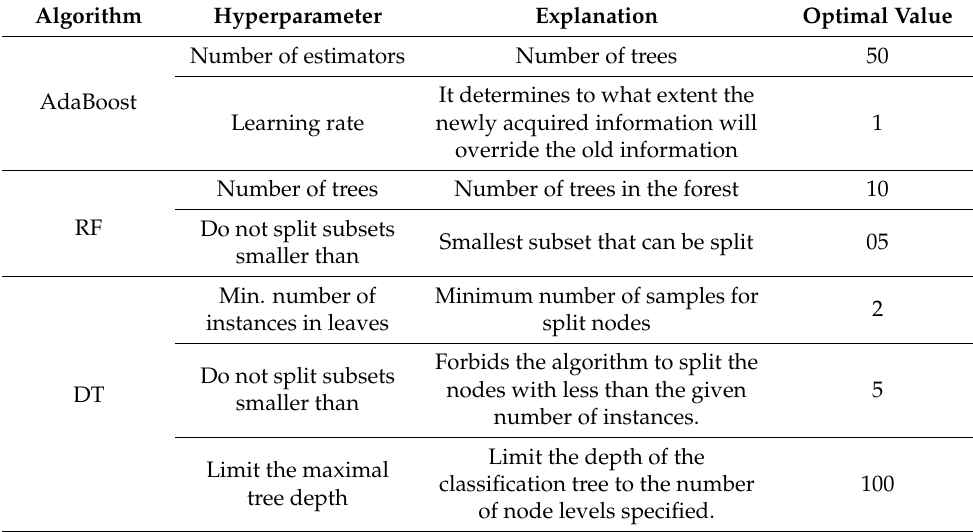
Table 3. Hyperparameter optimization